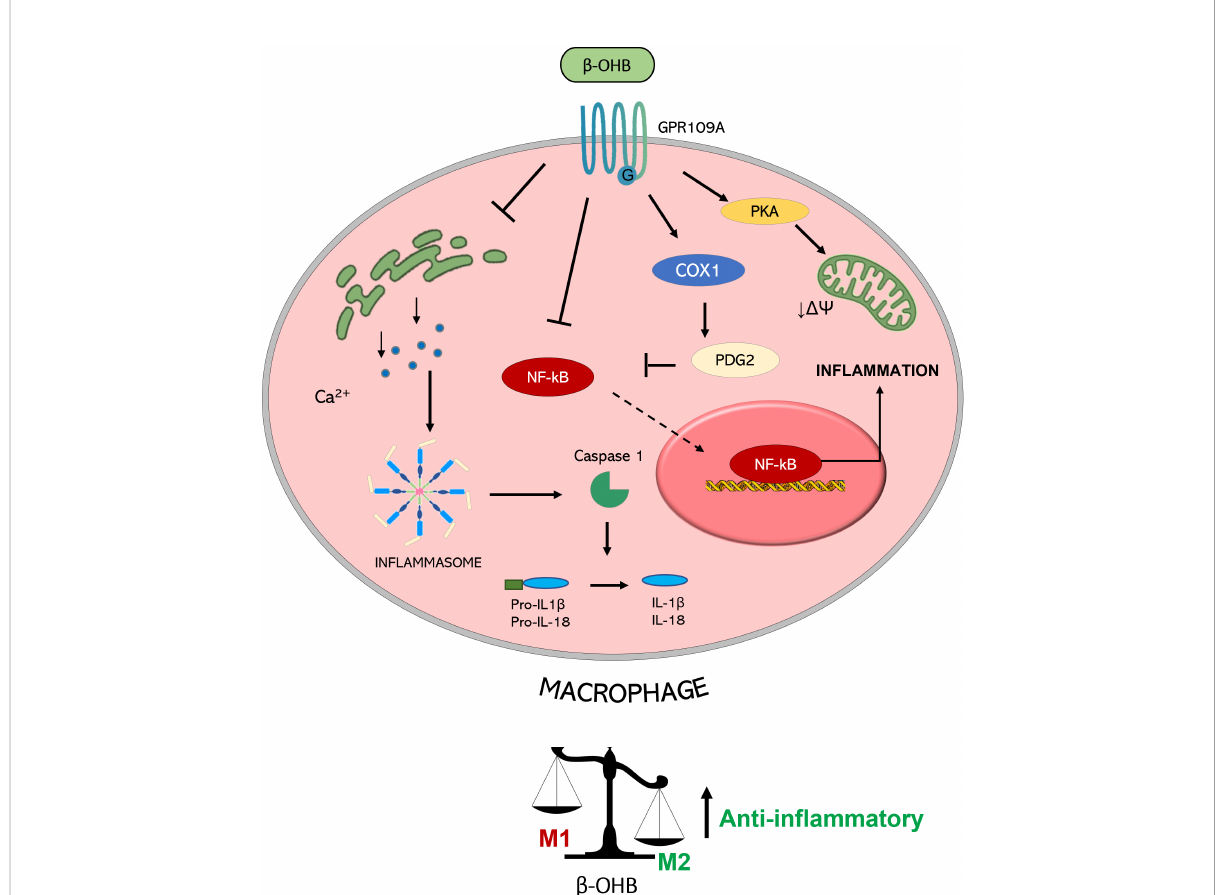
FIGURE 2 Molecular mechanisms triggered by GPR109A- b -OHB axis in macrophages. GPR109A engagement by b -OHB leads to a reduced in fl ammasome activation mediated by a reduction of Ca 2+ release from endoplasmic reticulum. This inhibition of in fl ammasome activity causes a lower IL-1 b and IL-18 release from macrophages. A reduction of in fl ammatory mediator release is also achieved by the inhibition of the transcription factor NF- k B which can be mediated by the COX-1-mediated synthesis of PDG2, a known inhibitor of NF- k B activity. All together these effects converge in the induction of an anti-in fl ammatory M2 phenotype of macrophages. This switch is also obtained by a PKA-mediated decrease in the mitochondrial membrane potential which guides M2 polarization. (PGD2: Prostaglandin D2; COX-1: Cyclooxygenase 1; PKA: Protein kinase A; NF- k B: nuclear factor- k B; IL: interleukin; b OHB: b -hydroxybutyrate; DY : mitochondrial membrane